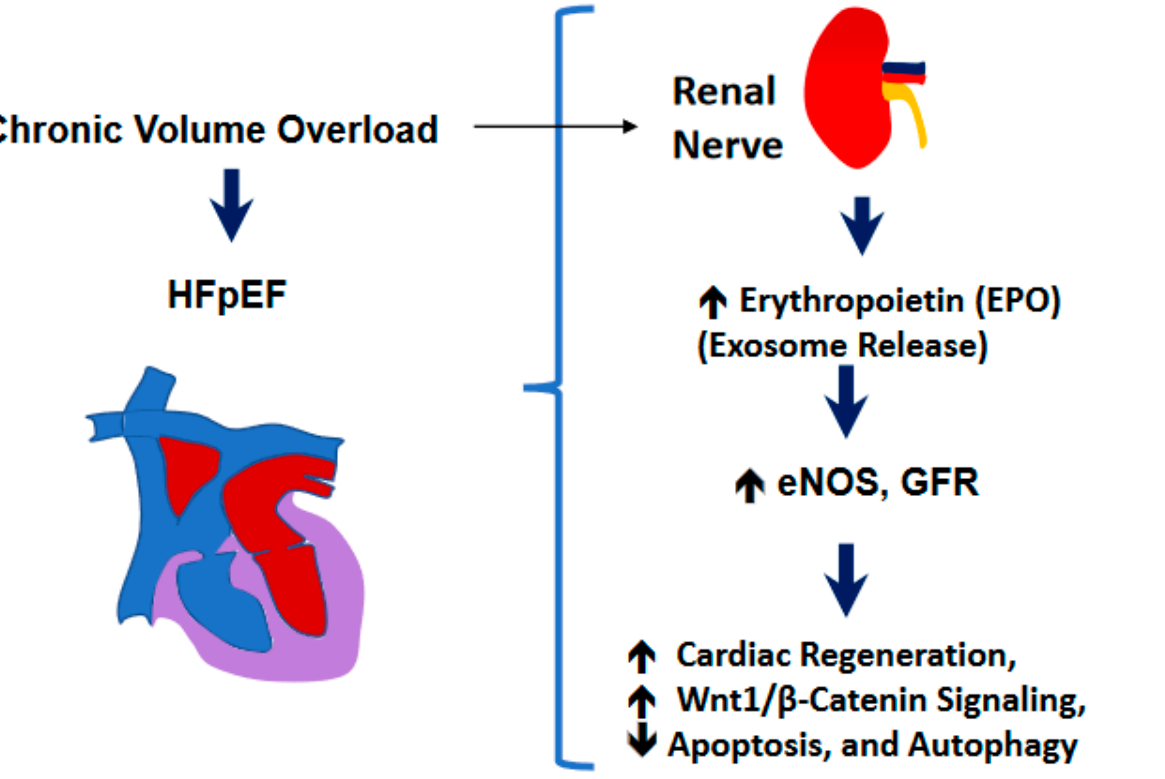
Figure 6. A schematic showing the renal mechanism of cardiac preserved ejection fraction (EF) during heart failure (HF).